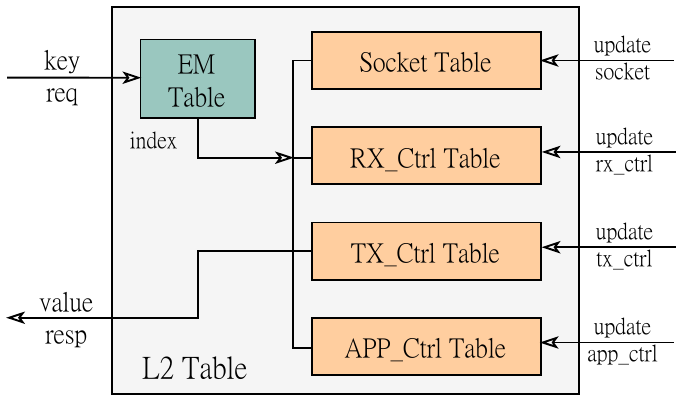
Figure 3. State management structure